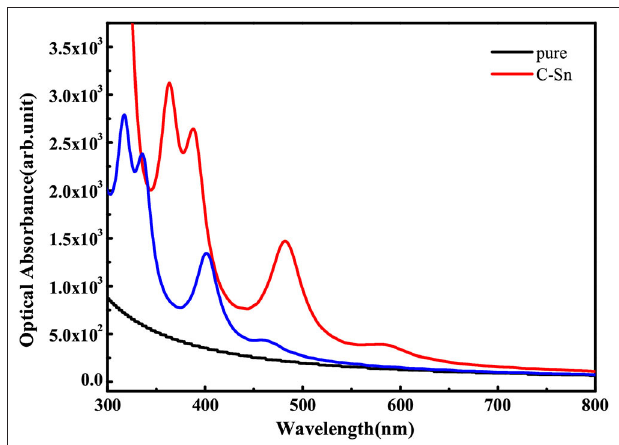
FIGURE 7 | The optical absorption spectra of pure and codoped GaN nanosheets.